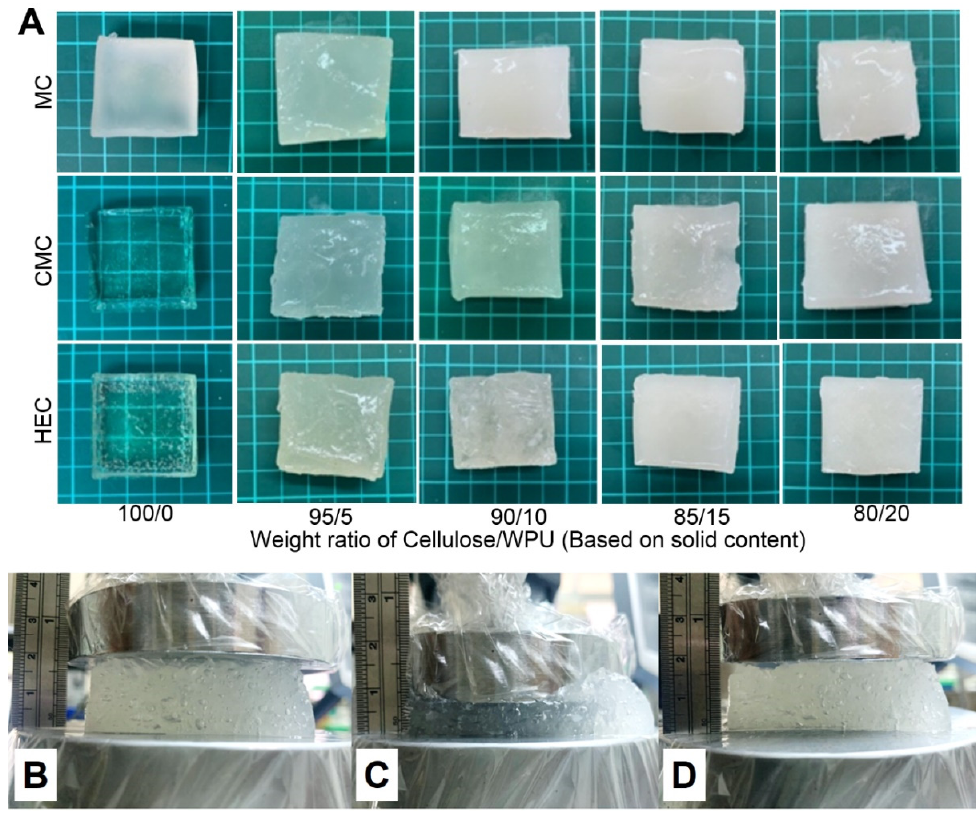
Figure 1. ( A ) Appearance of cellulose/WPU composite hydrogels. Changes in the appearance of composite hydrogel CMC-80/20 during compression ( B ); the appearance of the composite hydrogel before compression ( C ), after application of external force to strain 40%, and ( D ) after removal of the applied external force.